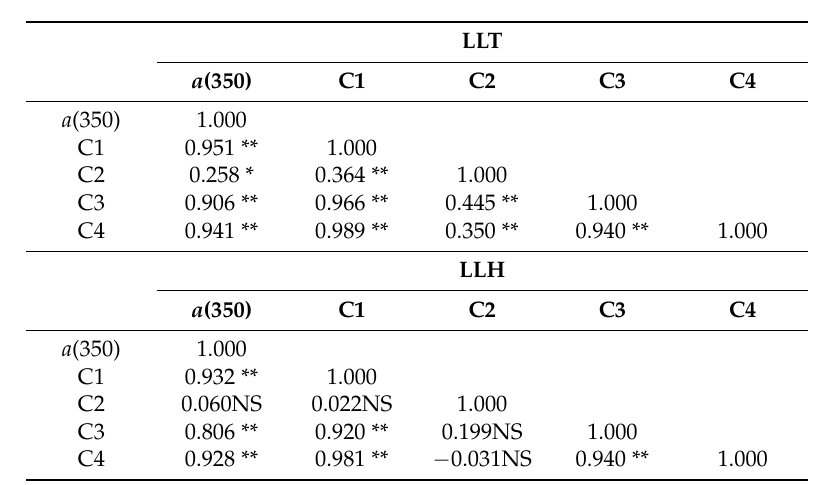
Table 3. Determination coefficients and statistical significance of the linear regression analysis among CDOM absorption and fluorescence intensities of components derived using the PARAFAC model.